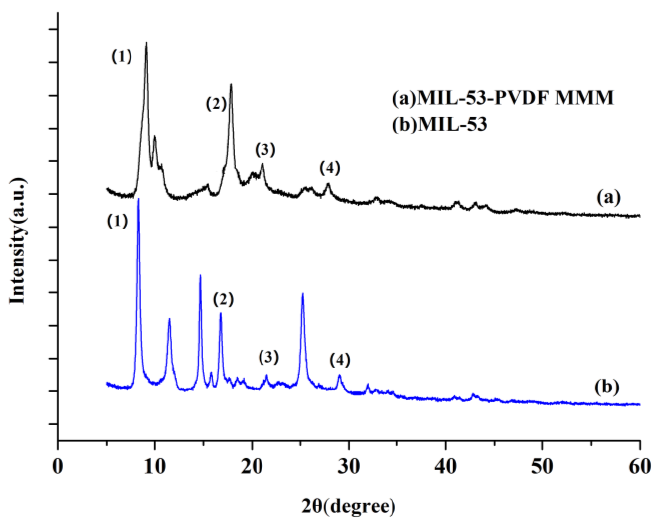
Figure 5. FTIR spectra of MIL-53 MMM ( a ), MIL-53 crystal ( b ).